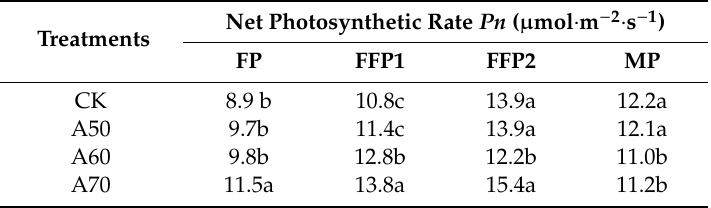
Table 1. Tomato net photosynthetic rate at di ff erent growth stages under ADI.